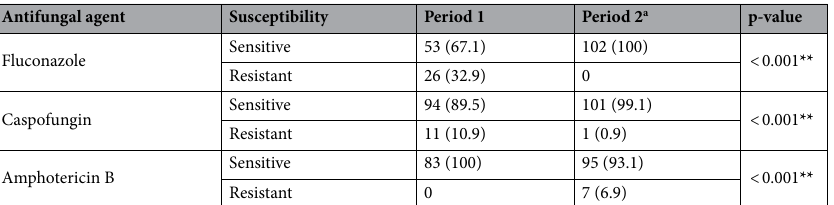
Table 5. The susceptibility of isolated C. albicans against fluconazole, caspofungin, and amphotericin B, during 2011–12 (period 1) and 2017–2018 (period 2). a Number (%) of children colonized with C. albicans. *No fluconazole-resistant isolates of C. albicans was found during period 2 (2017–2018). **Statistically significant by Fisher’s exact test.